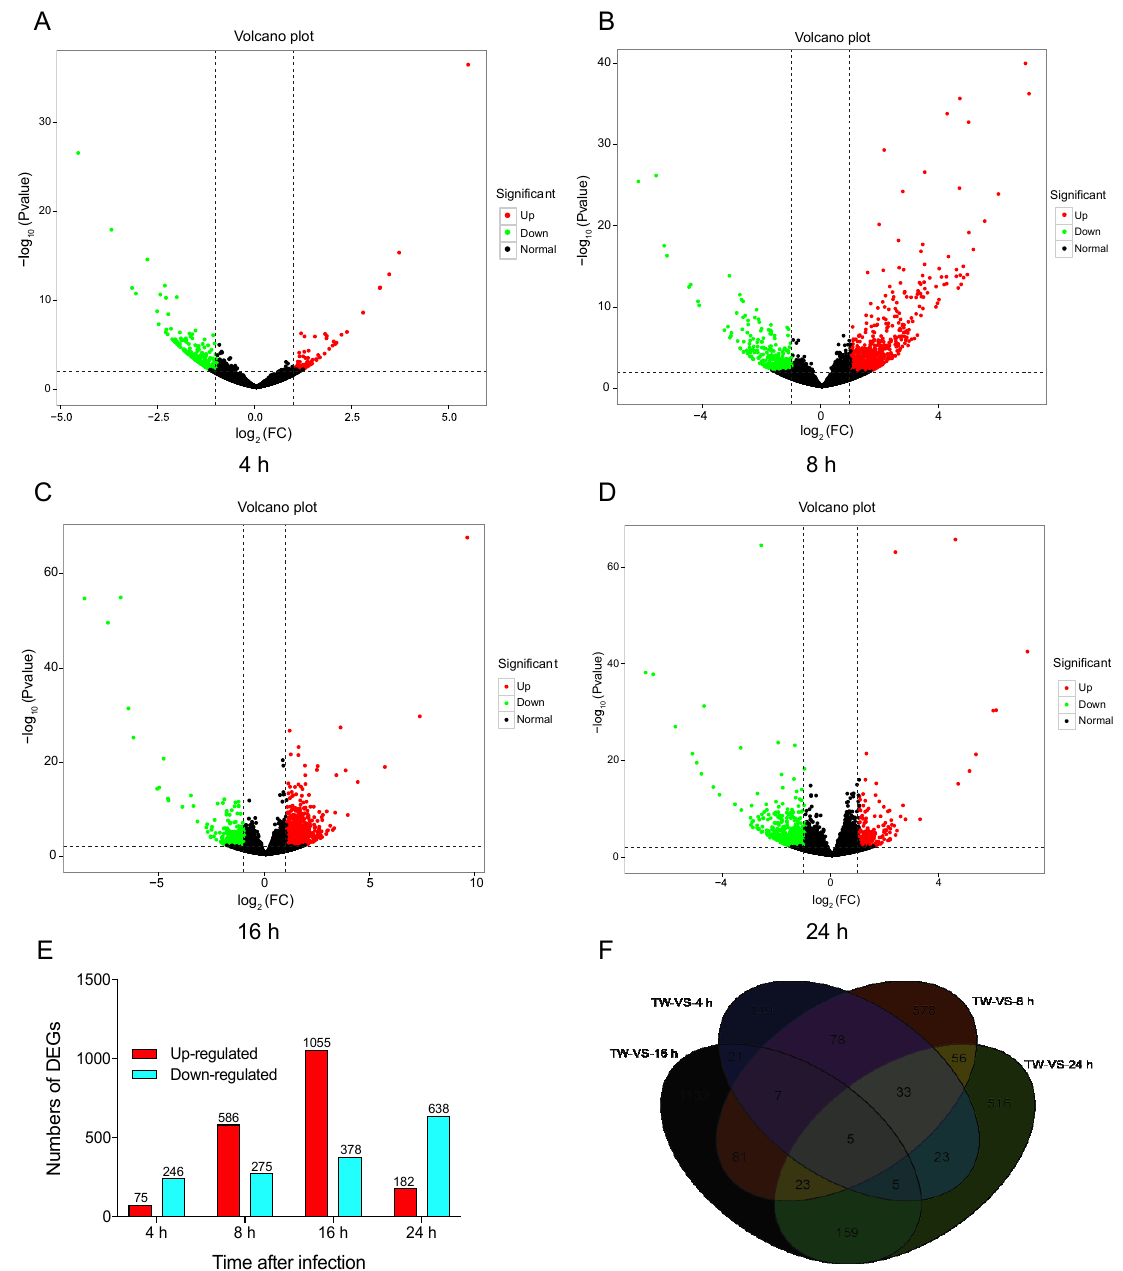
Figure 1. Volcano plot and number of differentially expressed genes (DEGs) after challenge with M. anisopliae at different periods. A: Volcano plot of DEGs at 4 h; B: Volcano plot of DEGs at 8 h; C: Volcano plot of DEGs at 16 h; D: Volcano plot of DEGs at 24 h; E: Numbers of DEGs at different period; F: Venn diagram of DEGs at 4 h, 8 h, 16 h, and 24 h post-infection.